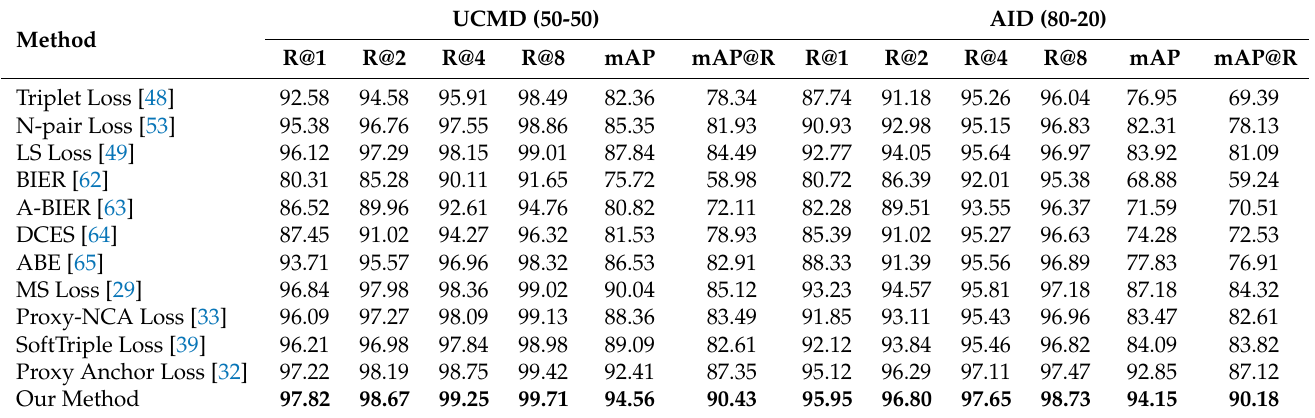
Table 7. Recall@K(%), mAP, and mAP@R performance comparison on UCMD and AID. The best results are shown in bold.